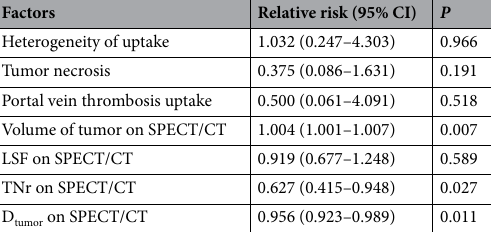
Table 3. Logistic regression analysis for risk factors of treatment response